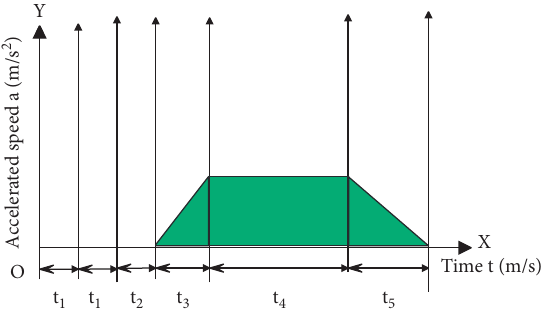
Figure 5: Variation of deceleration during